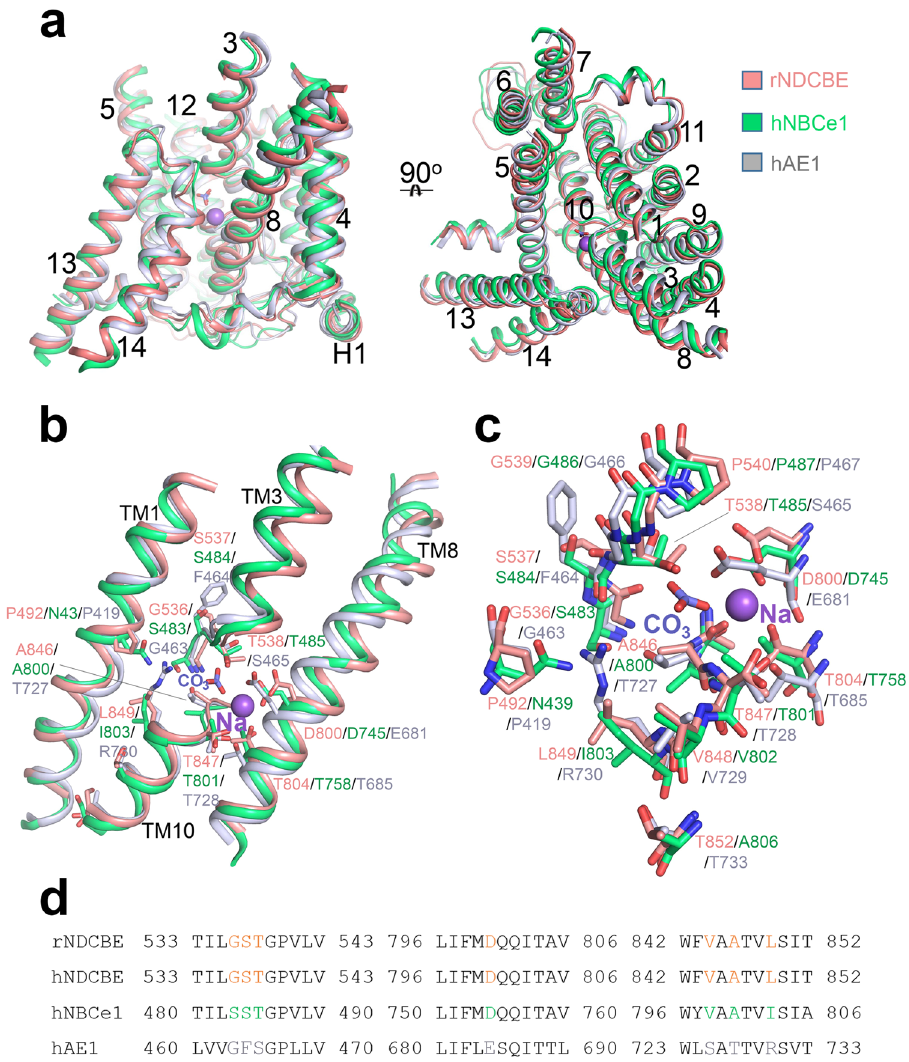
Fig. 5 Structural comparisons of NDCBE with AE1 and NBCe1. a The structural superimposition of NDCBE (salmon), AE1 (gray) and NBCe1 (green) in the TMD. For clarity, all loops including EL3 are not shown. b Comparison of NDCBE ion coordination residues with AE1 and NBCe1 residues located in or near the putative ion coordination area. c Magni fi ed view of b . d Sequence alignment showing residues in and near the ion coordination sites. The Clustal Omega program 62 was used. Na + and CO 3 2 ‾ are shown as a purple sphere and blue-red sticks